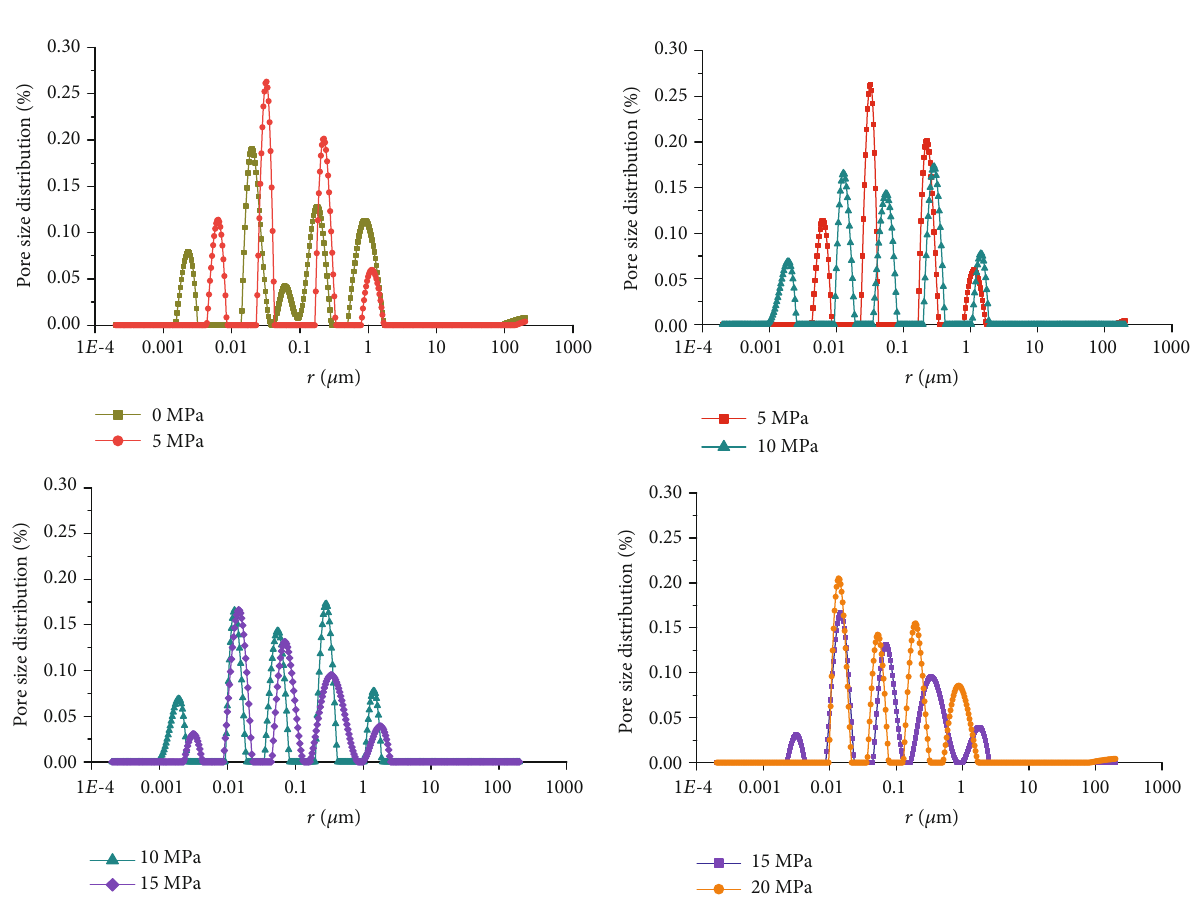
Figure 4: Pore size distribution of sandstone under di ff erent loads.